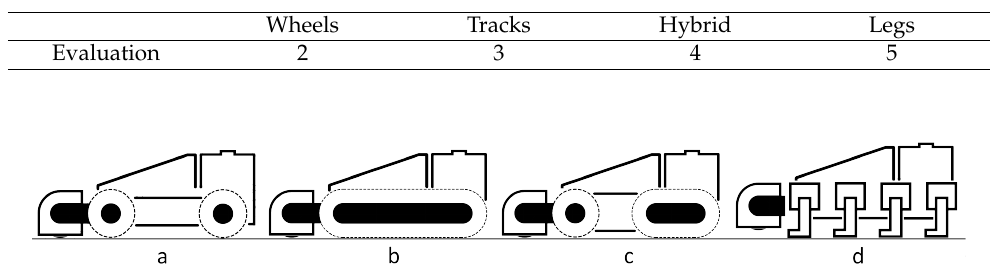
Figure 2. Key metrics—locomotion: ( a ) wheels; ( b ) tracks; ( c ) hybrid; ( d )